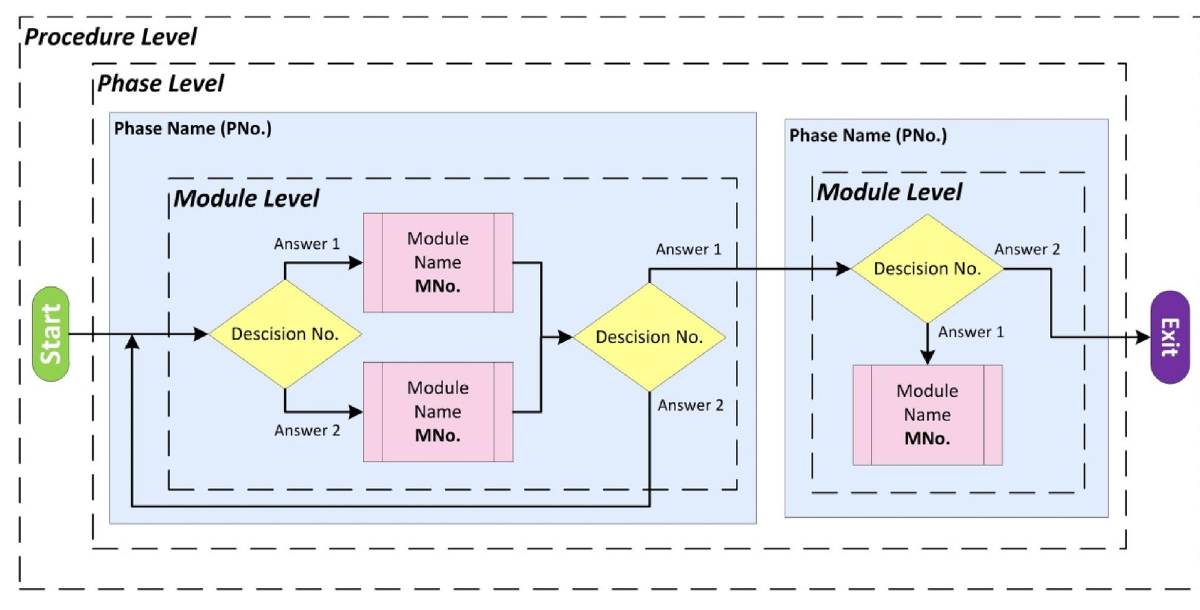
Figure 1. Different levels of granularity embodied in the developed surgical process